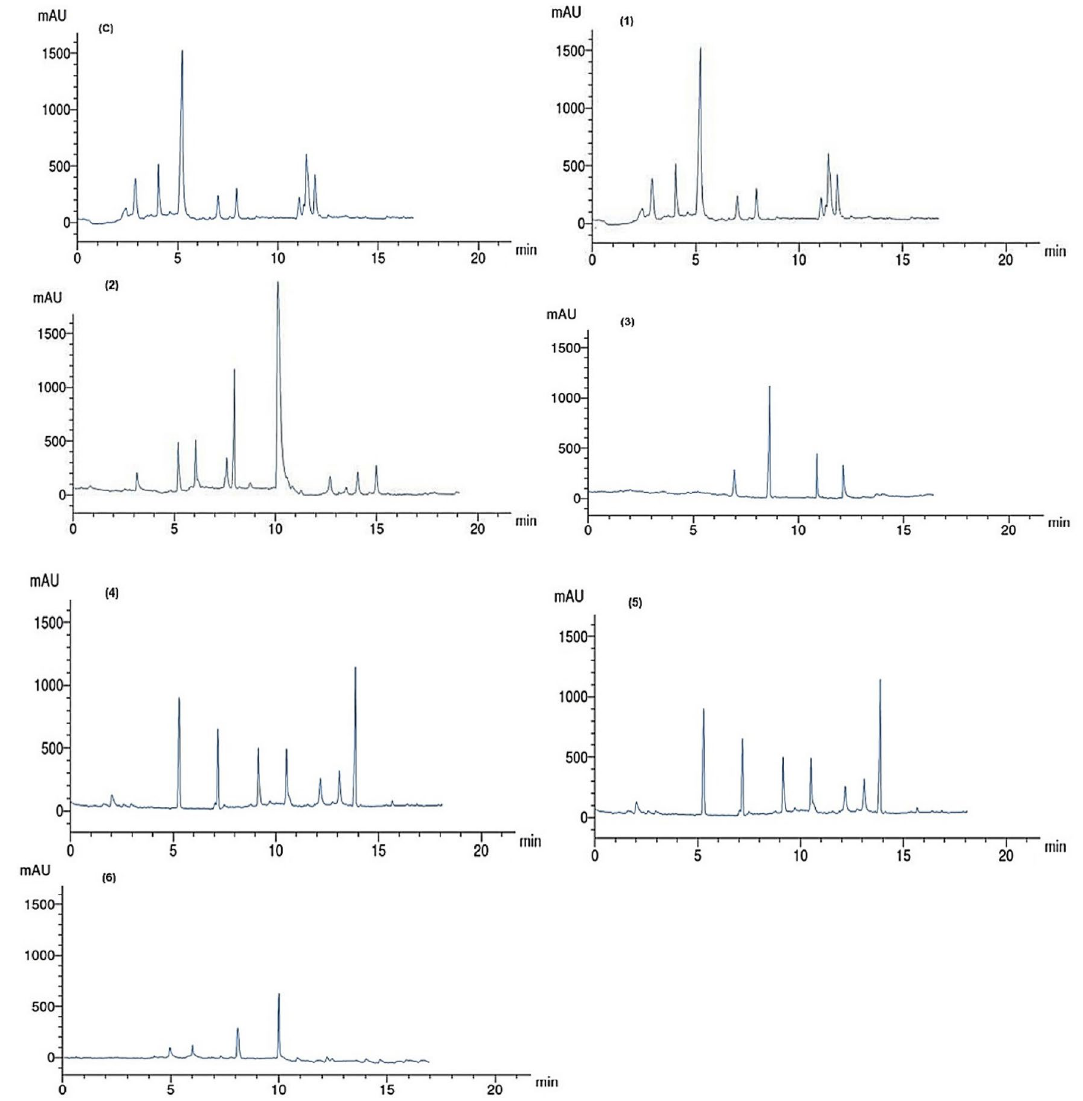
Figure 4. HPLC chromatograms of phenolic compounds identified in acetone extract from leaves of peach trees treated with ( 1 ) Ag NP 10 mL/L, ( 2 ) Ag NP 12.5 mL/L, ( 3 ) Ag NP 15 mL/L, ( 4 ) Zn NP 2.5 mL/L, ( 5 ) Zn NP 5 mL/L, and ( 6 ) Zn NP 7.5 mL/L compared to untreated trees